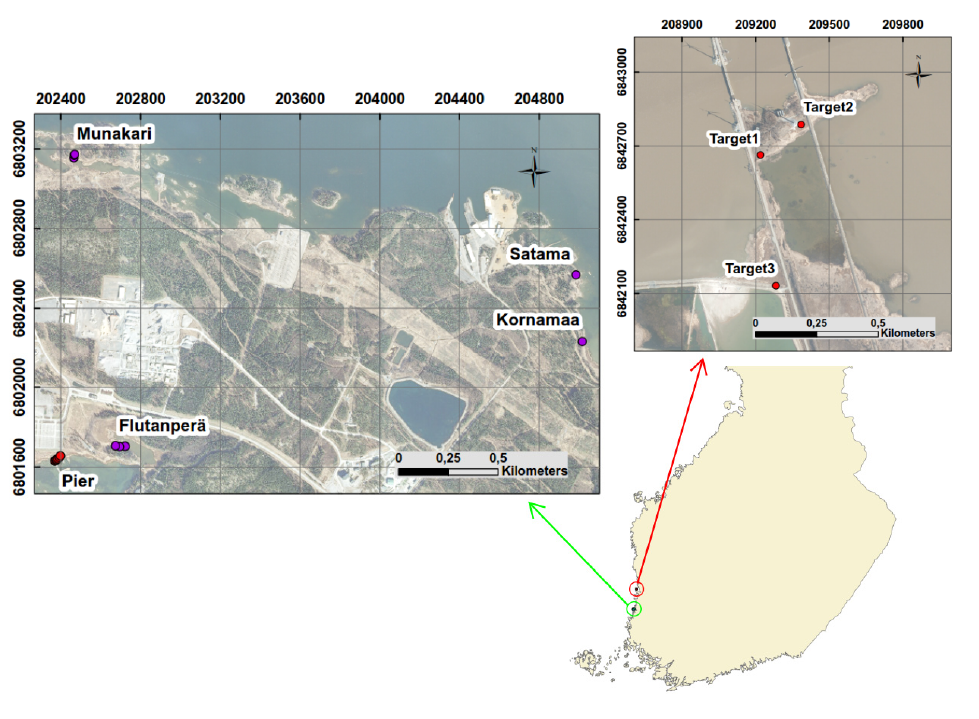
Figure 1. Overview of the study sites Olkiluoto ( left ) and Hilskansaari ( right ).